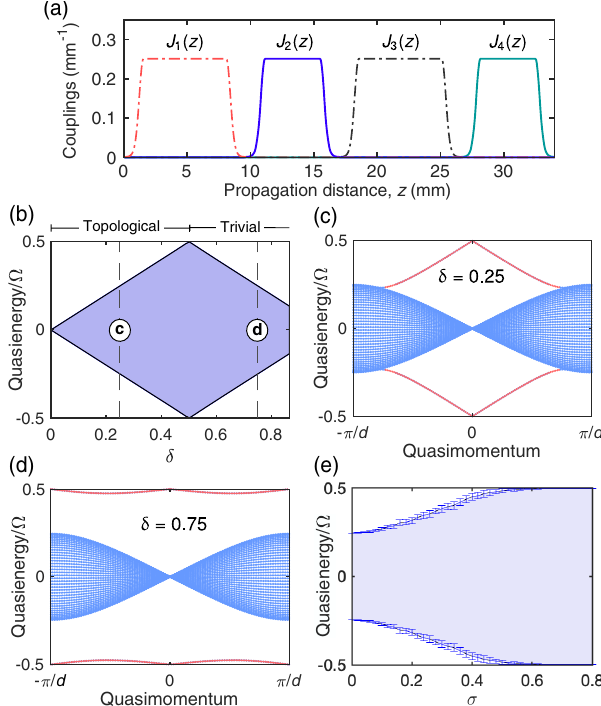
FIG. 5. (a) The variation of the couplings J 1 – 4 as a function of the propagation distance. The couplings resemble a steplike function with a fixed gradual rise and fall time. (b) Bulk quasienergy spectrum of the driven bipartite lattice as a function of δ . The blue (white) region indicates the linear bulk band (band gap); the band gap closes at δ ¼ 0 . 5 . (c),(d) Quasienergy spectra calculated using a strip geometry for δ ¼ 0 . 25 (topological) and δ ¼ 0 . 75 (trivial), respectively, indicated by the vertical dashed lines in (b). Topological unidirectional edge states (one per edge) appear for 0 ≤ δ < 0 . 5 . For δ > 0 . 5 , the edge states are trivial. (e) Quasienergy spectrum as a function of disorder strength σ in Λ 1 – 4 . The error bars indicate the standard deviation of maximum (minimum) quasienergies. The unavoidable small disorder 0 . 05 ) does not close the band present in the experiments ( σ exp ¼